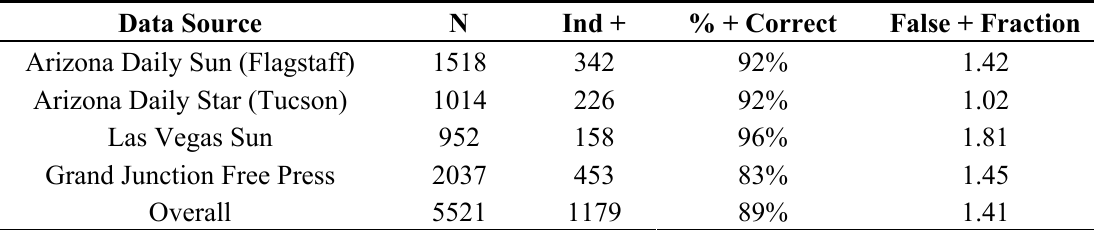
Table 6. Estimate of C’ -> E